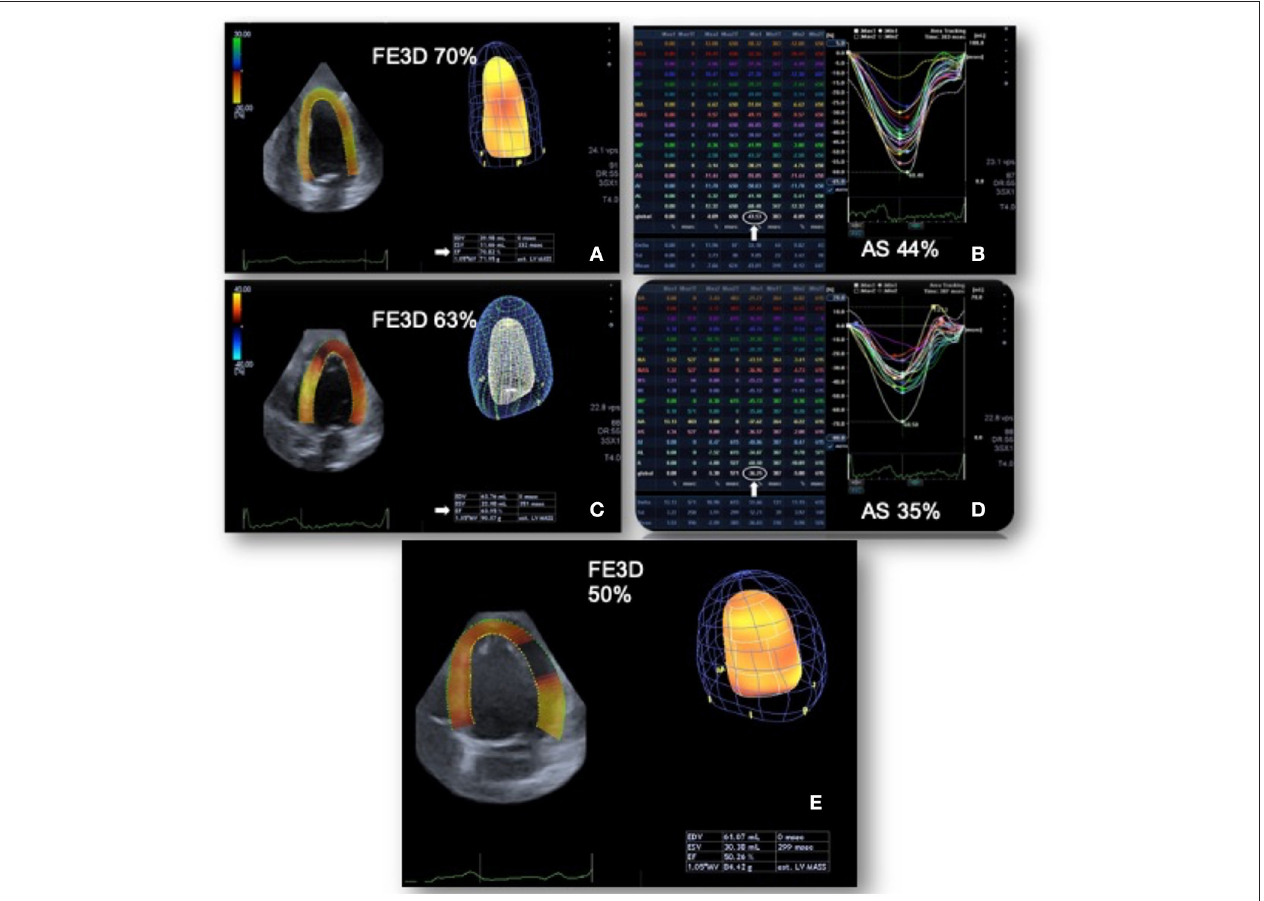
FIGURE 5 | Changes in global area strain derived from the three-dimensional speckle tracking echocardiography. Patient with breast cancer undergoing chemotherapy with doxorubicin. In the baseline evaluation, pre-chemotherapy, left ventricular ejection fraction (LVEF): 0.70 and 3DGAS: − 43.5% (A,B) . After a low cumulative dose of doxorubicin (120 mg/m 2 ), LVEF: 0.63 was observed (with reduction, but still preserved) and a significant decrease in three-dimensional global area strain (3DGAS) to − 36.2% (C,D) . Six months after the end of chemotherapy with doxorubicin (total cumulative dose of 240 mg/m 2 ), the LVEF dropped to 0.50 (E) . GAS, global area strain; LVEF, Left ventricle ejection